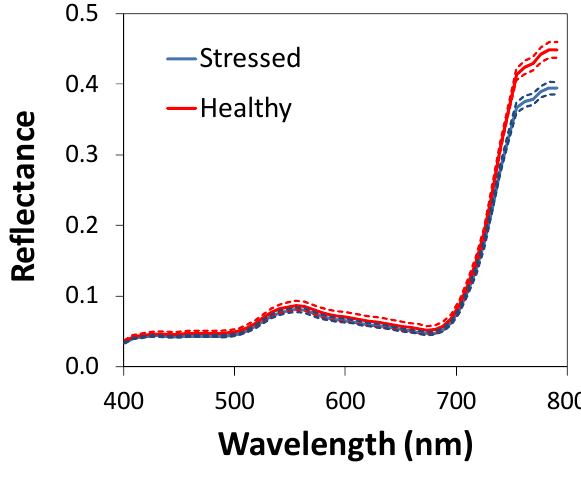
Figure 2. Airborne hyperspectral spectra from N-stressed and well-fertilized healthy blocks showing differences in the visible and near-infrared regions due to chlorophyll content absorption and canopy scattering variations. Dashed lines are the 95% confidence intervals around the treatment average (continuous